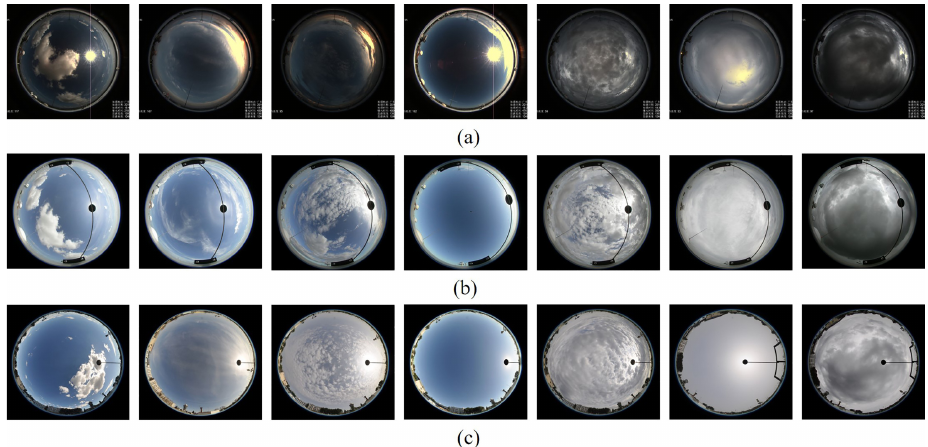
Figure 7. Cloud samples from ( a ) the CAMS database, ( b ) the IAP database, and ( c ) the MOC database. Table 1. The genera types and descriptions according to WMO and the sample number in each class of three databases. The Arabic numbers are used to denote the cloud class